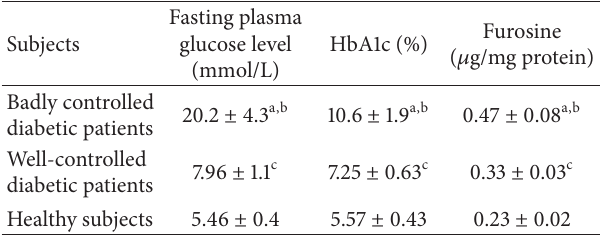
Table 1: Metabolic data (fasting plasma glucose level, HbA1c %, furosine) relative to badly controlled diabetic patients, well-con- trolled diabetic patients, and healthy